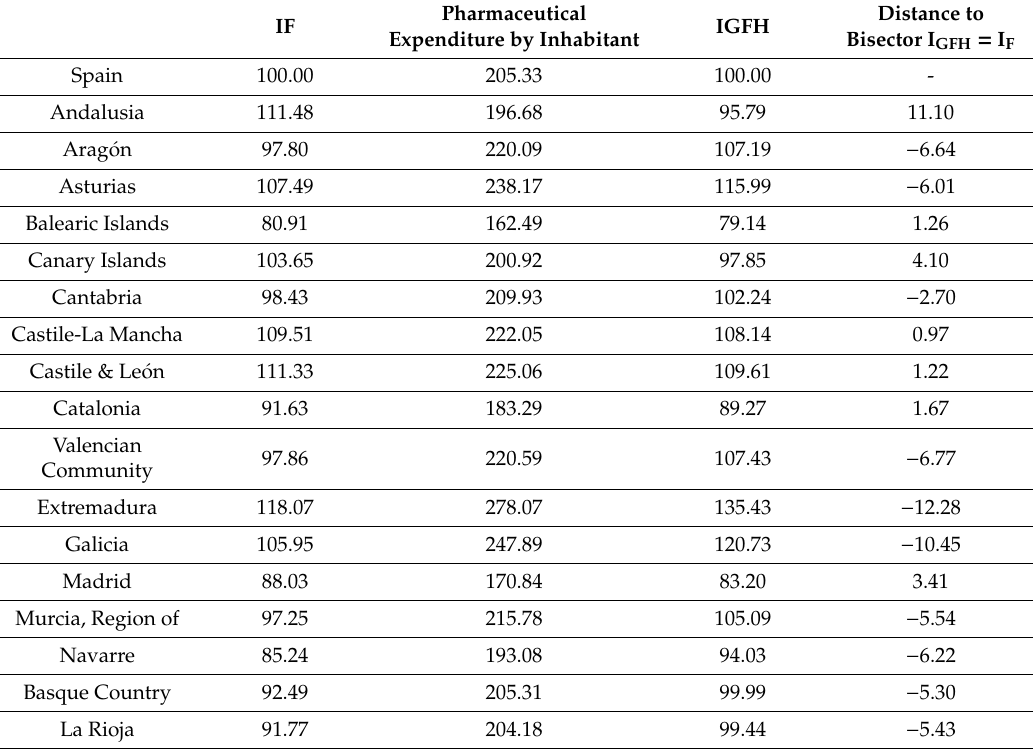
Table A3. Indices IF, Pharmaceutical Expenditure by Inhabitant,